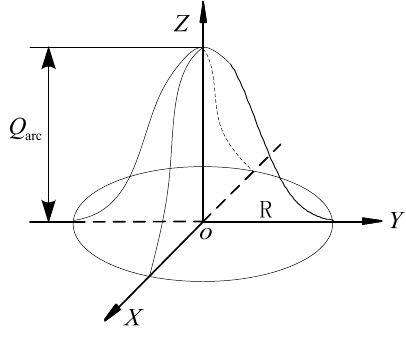
Figure 1. Schematic of the Gauss heat flux distribution.